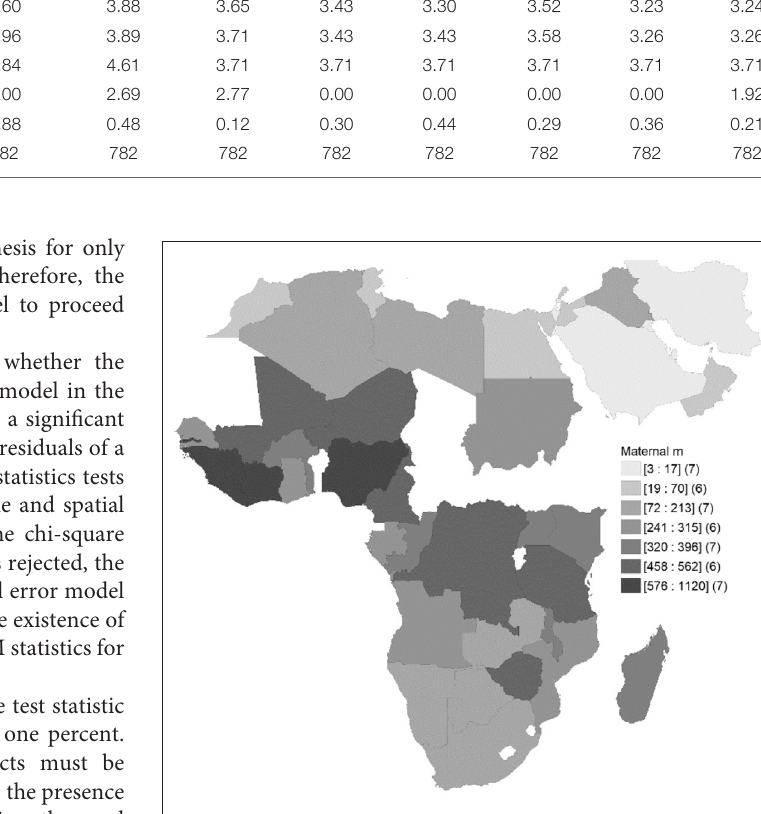
FIGURE 1 | Maternal mortality (per 100,000 livebirths) across select African countries, (2017).